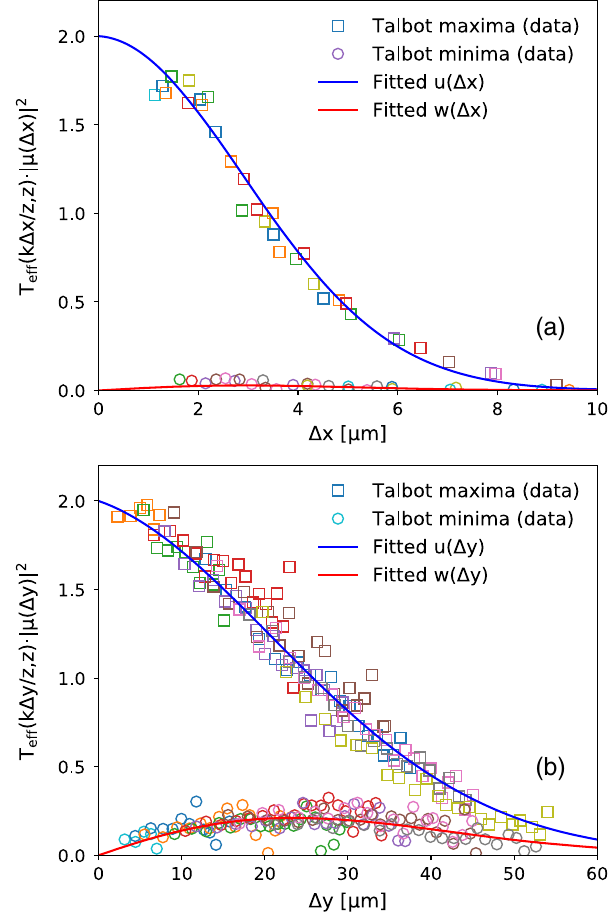
FIG. 10. Master curves describing the upper and lower enve- lopes of Talbot oscillations along the horizontal (a) and vertical (b) direction for κ ¼ 2 . 80% . Different colors represent different sample-detector distances z